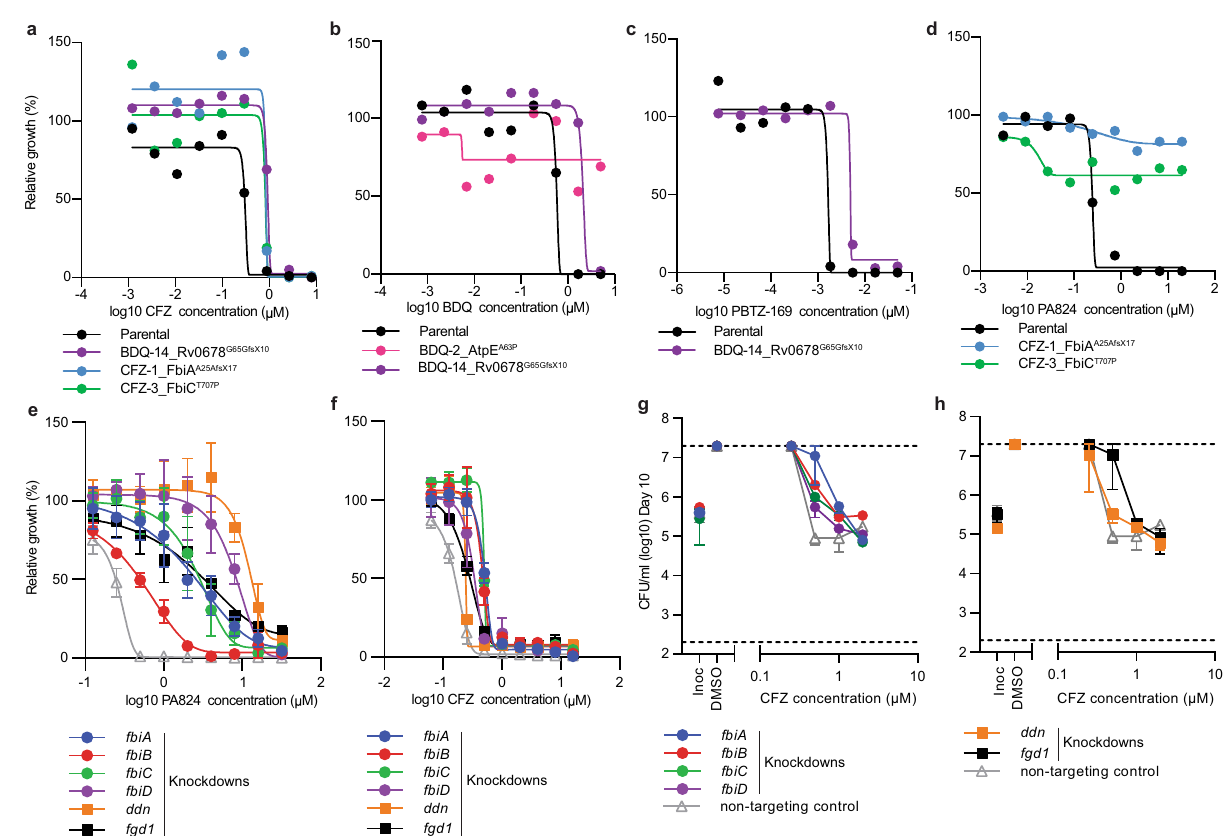
Fig.2|Collateraldrugresistanceindrug-resistantvariantsof M.tuberculosis is mediated via diverse mechanisms. a – d Dose – response curves for selected drug- resistant variants and the drug-susceptible parent against selected antibiotics (highlightingcollateraldrugresistance).Strainnamesandcandidatemutationsare listed below each dose-response. e , f Relative growth of CRISPRi knockdown and non-targeting control strains against PA824 and CFZ. g , h Minimum bactericidal concentration assays for CRISPRi knockdown and non-targeting strains against